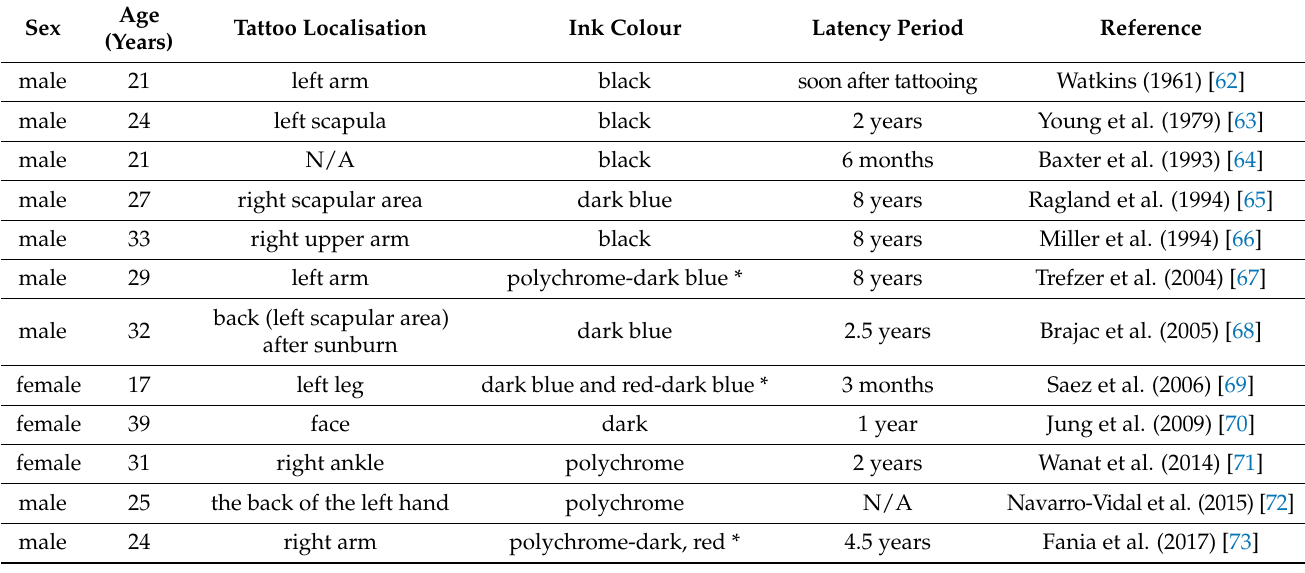
Table 2. Epidemiological and clinical characteristics of the reported cases of warts on